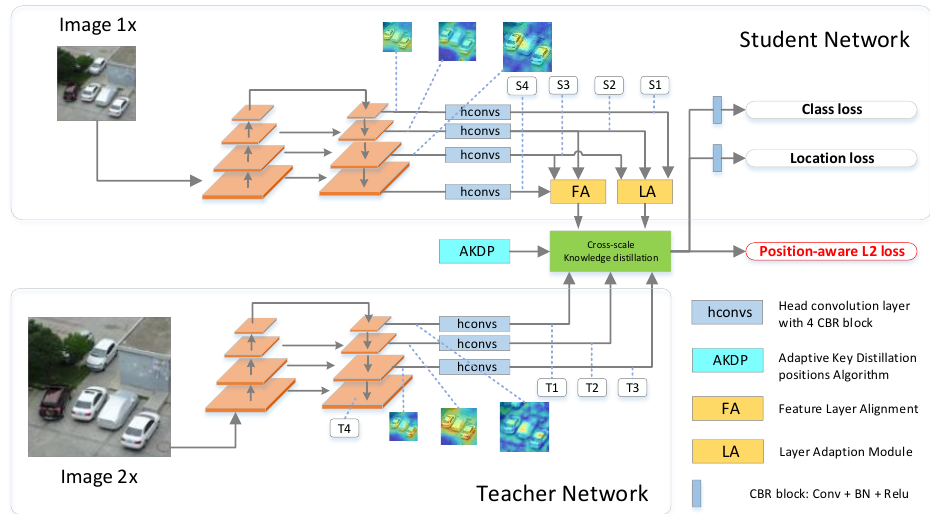
Figure 3. Cross-scale knowledge distillation architecture of proposed ZoomInNet. The feature maps from teacher and student networks are aligned via LA and FA mechanism, and then AKDP algorithm is used to calculate the key positions at feature maps, the position-aware L2 loss is used to measure the difference between feature maps from the teacher and student